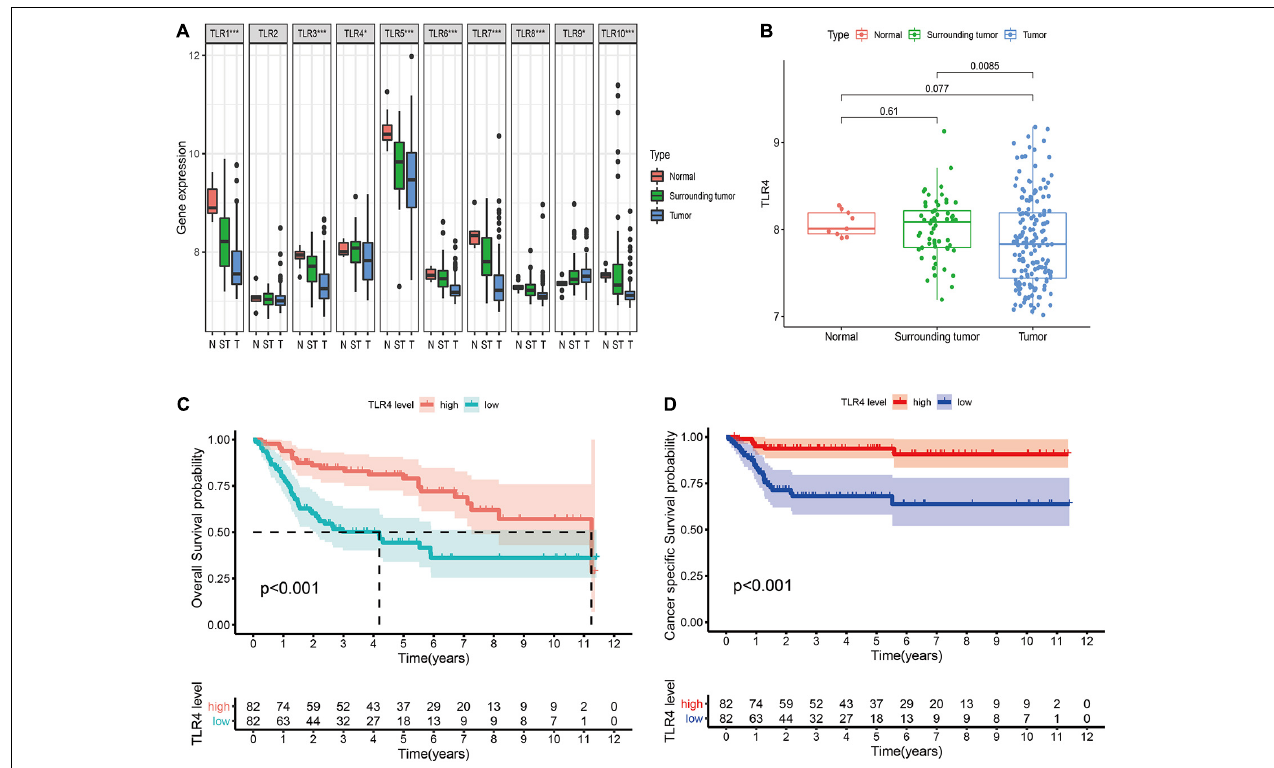
FIGURE 1 | Comprehensive analysis of ten TLRs in bladder cancer in GSE13507. (A) Differential expression of 10 TLRs in normal tissue ( n = 9), surrounding tumor tissue ( n = 58), and tumor tissue ( n = 165). (B) The TLR4 expression in three tissue types. (C) Prognostic value of TLR4 to predict the overall survival in bladder cancer patients. (D) Prognostic value of TLR4 to predict the cancer-specific survival in bladder cancer patients.